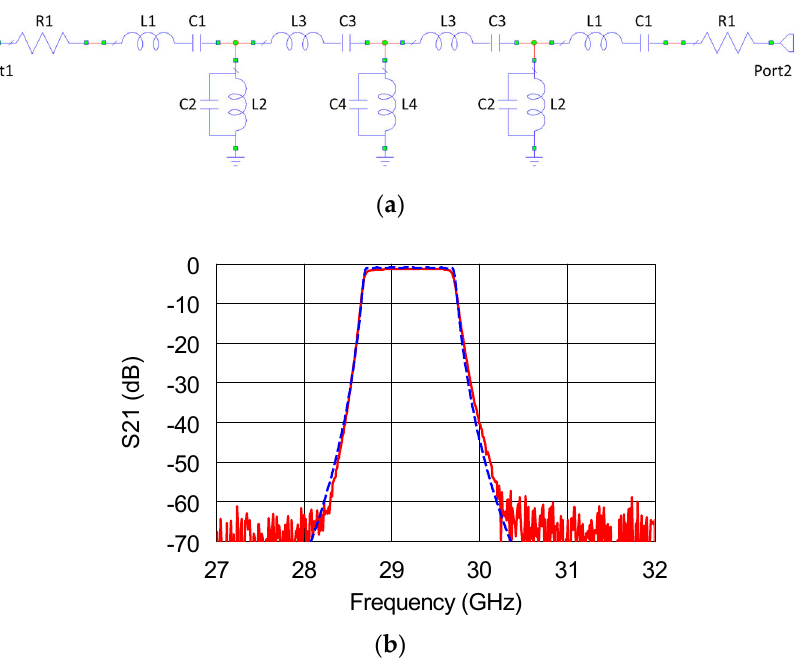
Figure 5. ( a ) Schematic and ( b ) insertion loss of the measured (red solid line) and simulated (blue dashed line) S 21 for the PB1182WB filter.